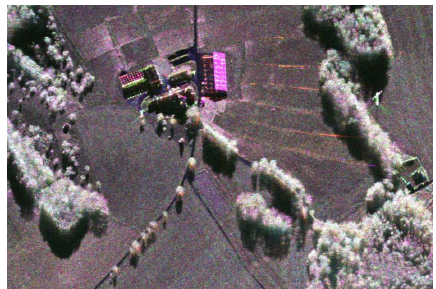
Figure A5. Radar image, scale T = [ 30,30 ] cm, “Dirac” shaped